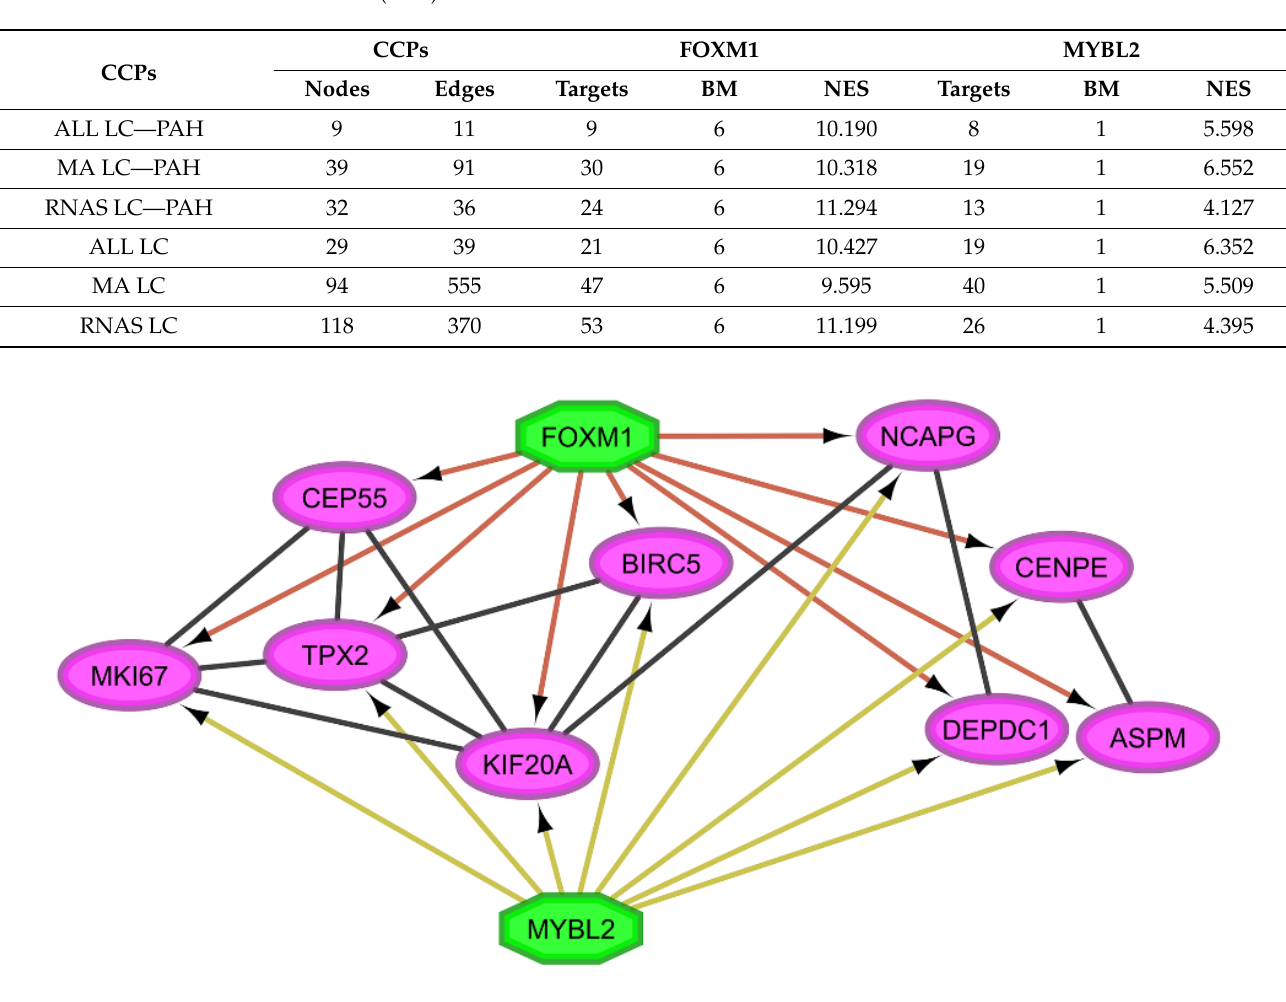
Figure 3. Common connection pattern (CCP) of all lung cancer co-expression networks and pulmonary arterial hypertension co-expression networks. In green are the two main regulators of the genes (magenta) in the CCP.